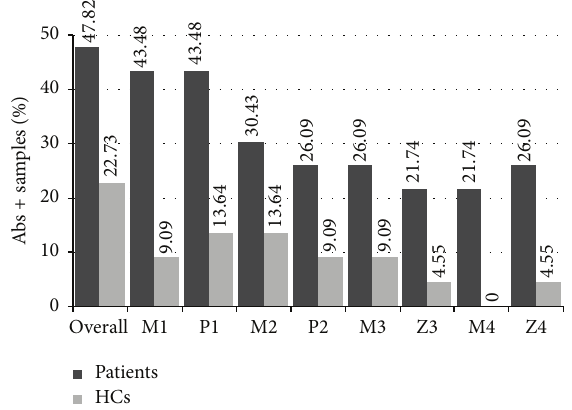
Figure 1: Prevalence of Abs against MAP, proinsulin, and ZnT8 homologous peptides in children at risk of T1D and healthy controls. Sera were tested in duplicate for their reactiv- (M1); PI 64 ity against plate-coated peptides: MAP1,4 𝛼 gbp 157 – 173 – 80 (P1); MAP2404c 70 (M2); PI 46 (P2); MAP3865c 133 (M3); – 85 – 61 – 141 (Z3); MAP3865c 125 (M4); ZnT 8 178 (Z4). Percent- ZnT 8 186 – 194 – 133 – 186 age of children with Abs positivity to any of the analyzed peptides is indicated by the first column pair. Dark bars represent children at risk of T1D; light grey bars correspond to